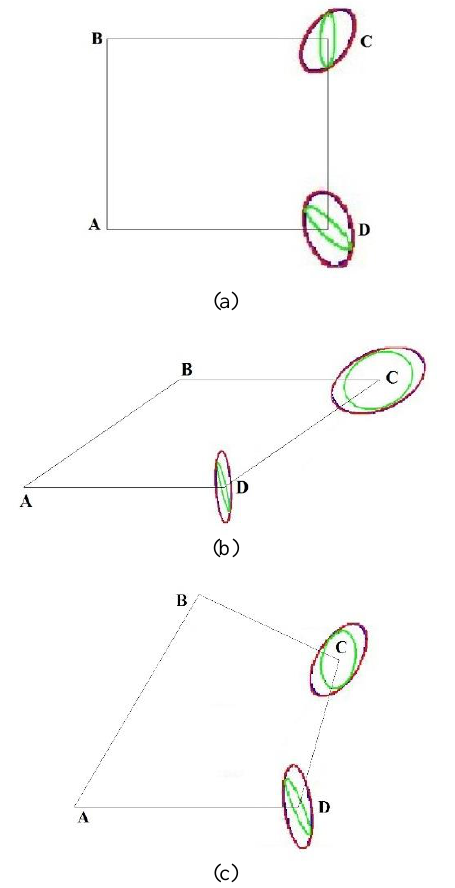
Figure 7. Error ellipses for results obtained from three adjustment methods of the true-weighted Least Squares (shown in green), the Least Squares with a constant and hypothetical weight of 5 seconds (shown in red) and the Doubly-braced Quadrilateral (shown in blue) for simulated data for (a) square (b) parallelogram (c) irregular quadrilateral specified in section 3.2. The actual accuracy of the observations is considered with a random error of 10 seconds for the first vertex, 8 seconds for the second vertex, 4 seconds for the third vertex, and 1 second for the fourth vertex of the traverse. Error ellipses are magnified by 1000 times.